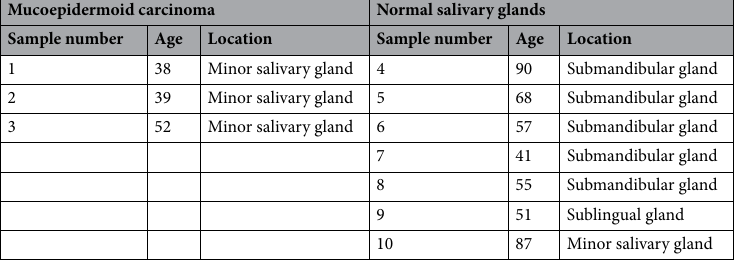
Table 3. Summary of salivary glands used in this